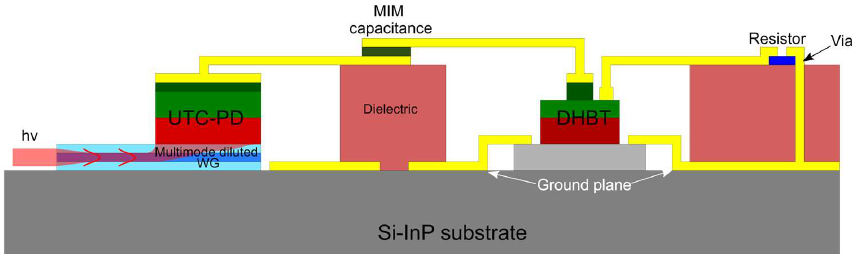
Figure 1. Schematic view showing future monolithic integration of the Uni-traveling-Carrier photodiodes (UTC-PD) with Double Hetero junction Bipolar Transistors (DHBT) to be used, for instance, in integrated THz transceivers.